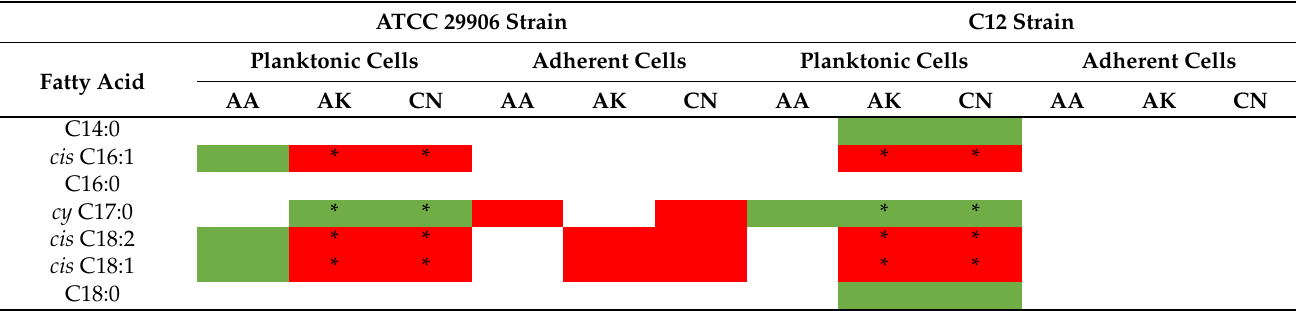
Table 4. Statistically significant changes in the FAs levels induced by AA, AK, or CN treatment in the planktonic and adherent cells of the P. mirabilis strains, determined by Fisher’s test. ATCC 29906 Strain C12 Strain Planktonic Cells Adherent Cells Planktonic Cells Adherent Cells